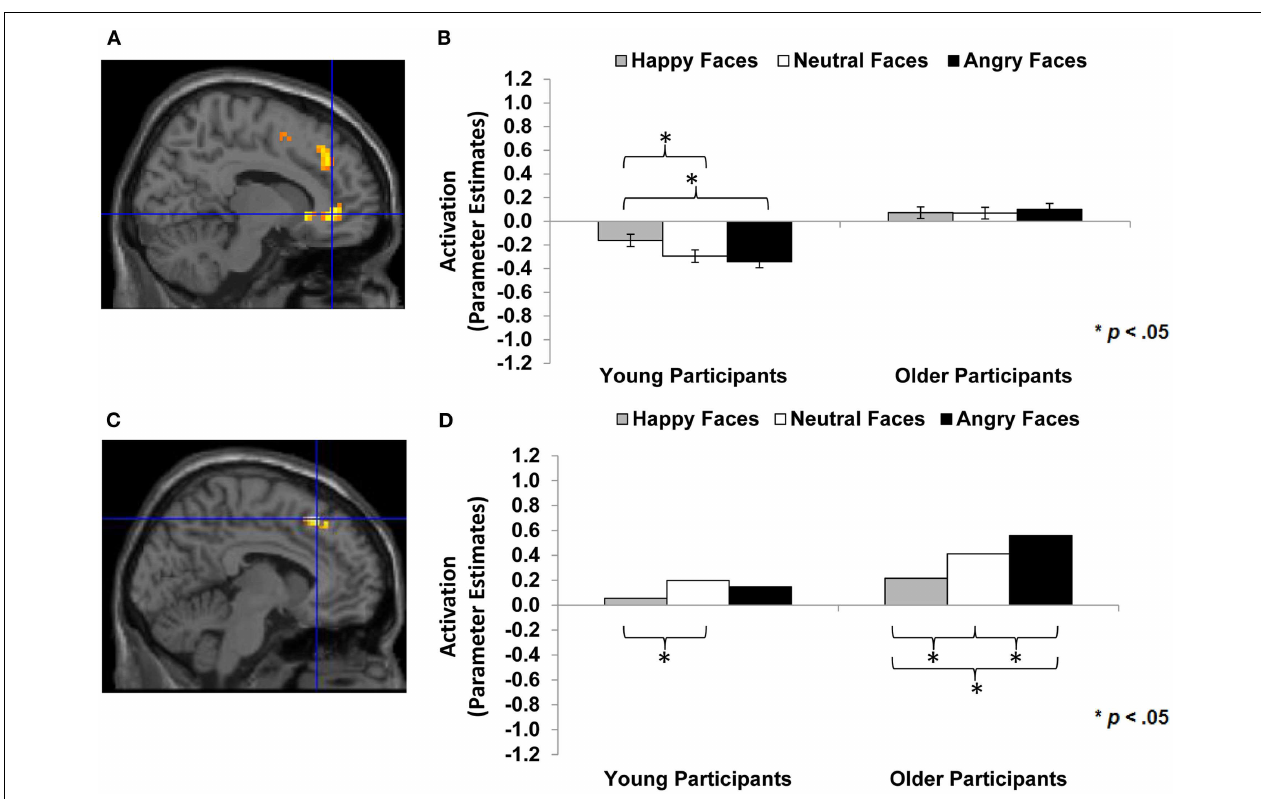
single value for each condition of interest, respectively. (C) Left medial frontal gyrus, superior frontal gyrus (BA 8, 6; MNI: x =− 6, y = 27, z = 51; cluster size: 23 voxels; maximum F -value for cluster: 9.50).The region of activation represents the F -map of the contrast; it is displayed on the standard reference brain in SPM.The crosshair indicates the peak voxel (local maximum) within the region of activation. (D) Bar graphs show the mean left dmPFC parameter estimates (beta values) separately for facial expression and age of participant (across age of face); betas for this region of activation identified by the F -contrast happy vs. angry faces by age of participant were extracted for each individual from a 5-mm sphere around the local maximum within the region of activation and averaged to produce a